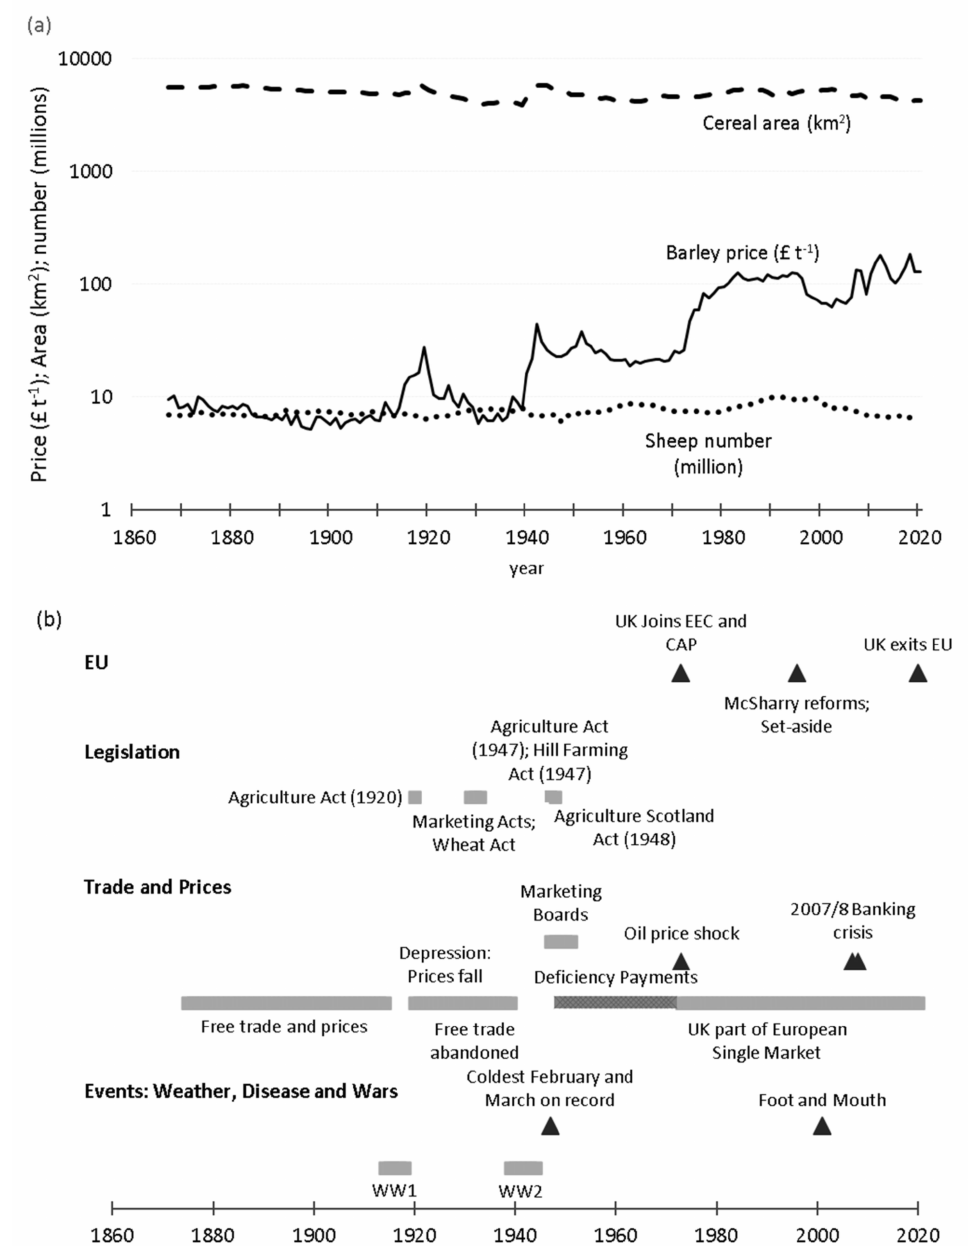
Figure 1. ( a ) Price of barley (£/t), number of sheep (millions), and area of cereals (km 2 ) for Scotland from 1867–2020. The plot is scaled with natural logarithms. ( b ) selected major legislative, trade, commodity price, weather, war, and disease events from